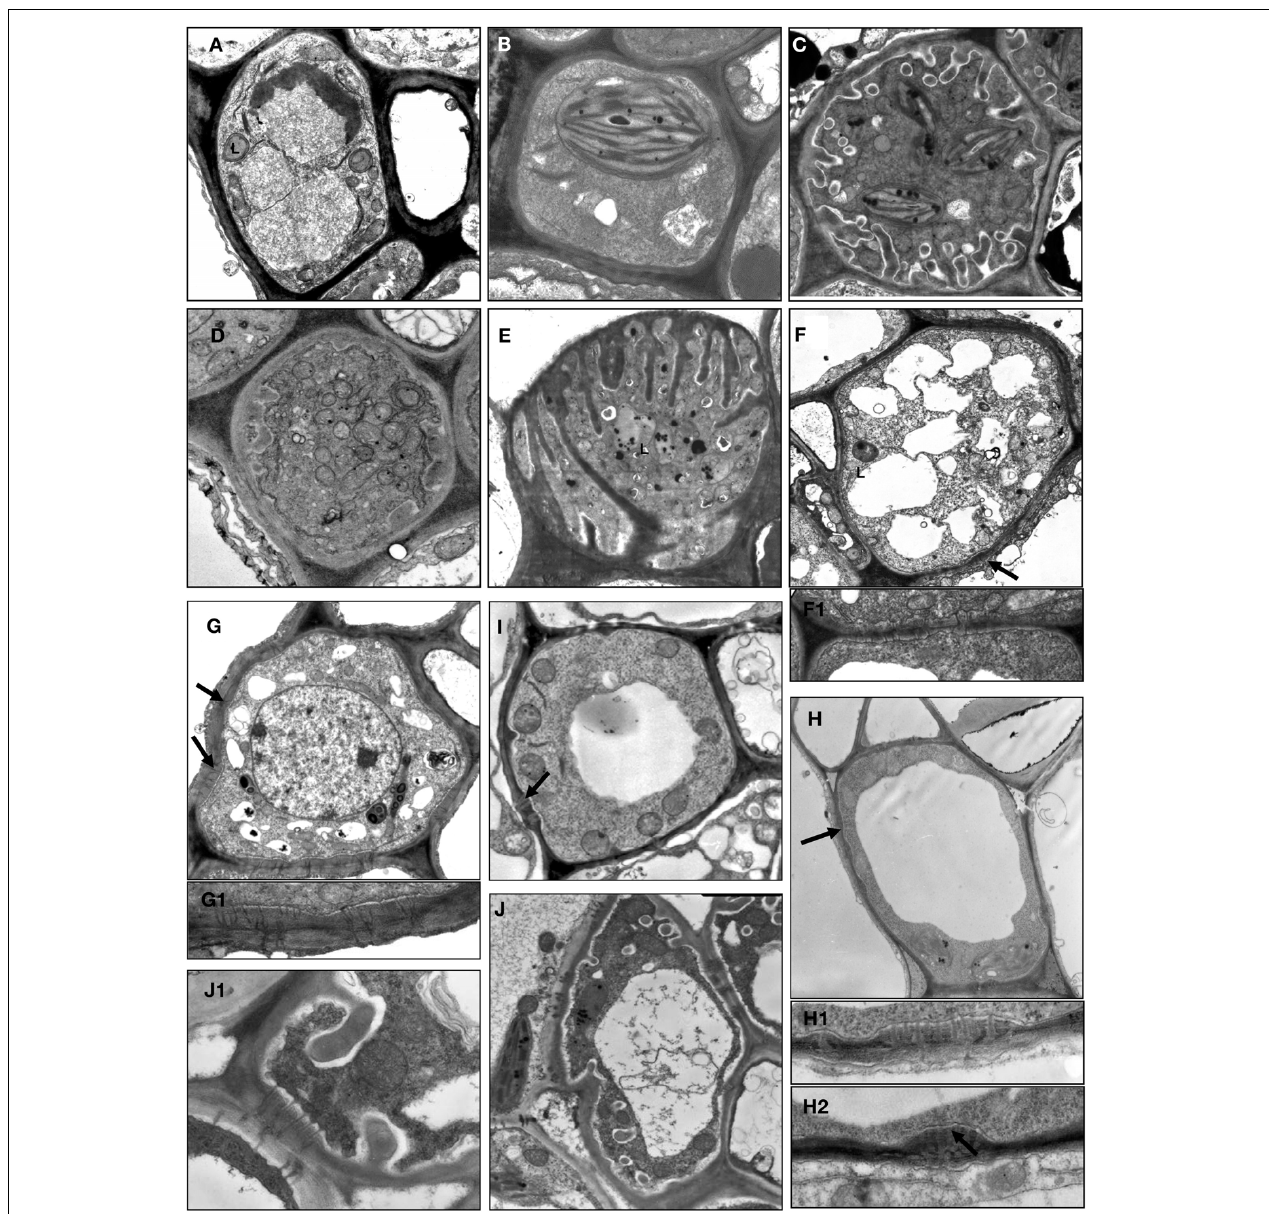
FIGURE 1 | Structural diversity of companion cells in minor veins in representative species according to classification in Table 1. L, leucoplast; arrow points on plasmodesmal fields between companion cells and bundle sheath cells at several subfigures. (A) Swertia obtusa , “ordinary cell” OC-a: plasmodesmal fields and protuberances of the cell wall are absent; plastids are leucoplasts. (B) Vinca minor , “ordinary cell” OC-b: neither protuberances of the cell wall nor plasmodesmal fields are present; plastids are well-developed chloroplasts. (C) Onosma gmelinii , “transfer cell” TC-a: multiple protuberances of the cell wall are present while no plasmodesmal fields are formed; plastids are well-developed chloroplasts. (D) Dracocephalum peregrinum , “transfer cell” TC-b with leucoplasts (not shown) in the abaxial sieve element-companioncell complex (two other sieve element-companioncell complexes in this minor vein contain intermediary cells). (E) Gentiana aquatica , “transfer cell” TC-c: multiple protuberances of the cell wall of unusual flange morphology are present, plasmodesmal fields are absent, plastids are leucoplasts. (F) Hamelia patens , companion cell